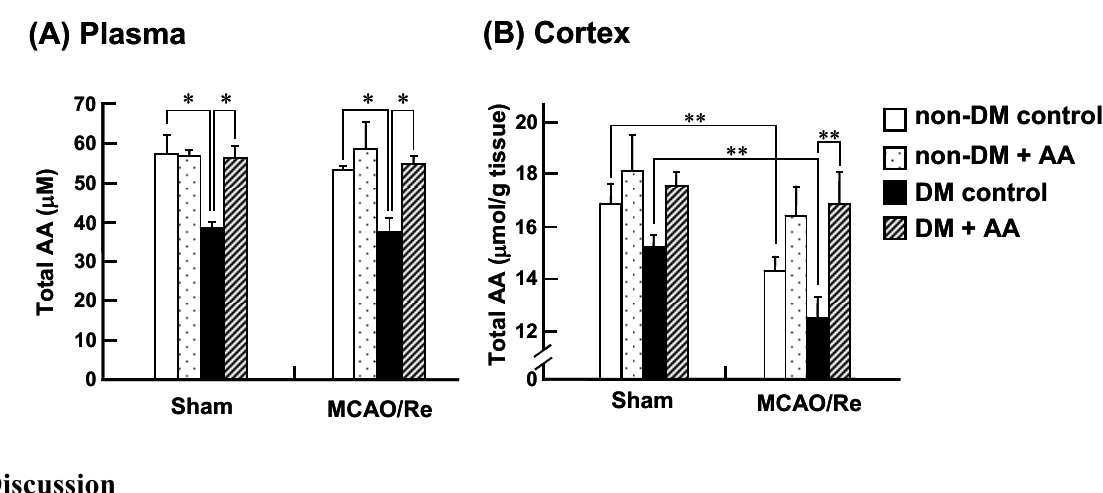
Figure 10. Effects of AA supplementation on levels of total AA (AA + DHA) in the plasma and cortex of nondiabetic and diabetic rats. Total AA (AA + DHA) levels in the plasma ( A ) and cortex ( B ) measured in nondiabetic and diabetic rats after MCAO/Re. The data are presented as mean ± SD ( n = 3–6). * p < 0.05, ** p <